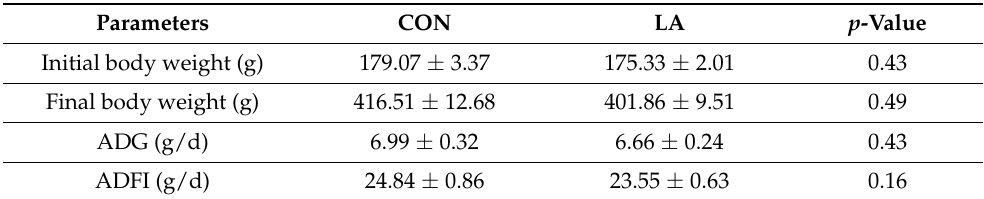
Table 1. Effect of α -lipoic acid on rat growth performance.